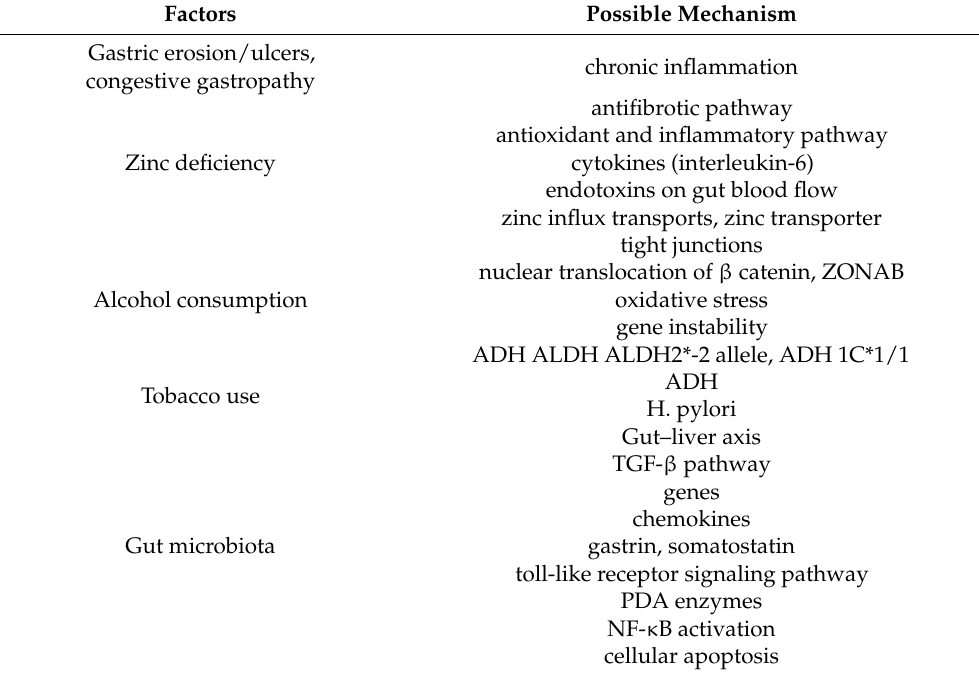
Table 1. Factors associated with liver cirrhosis contribute to upper gastrointestinal